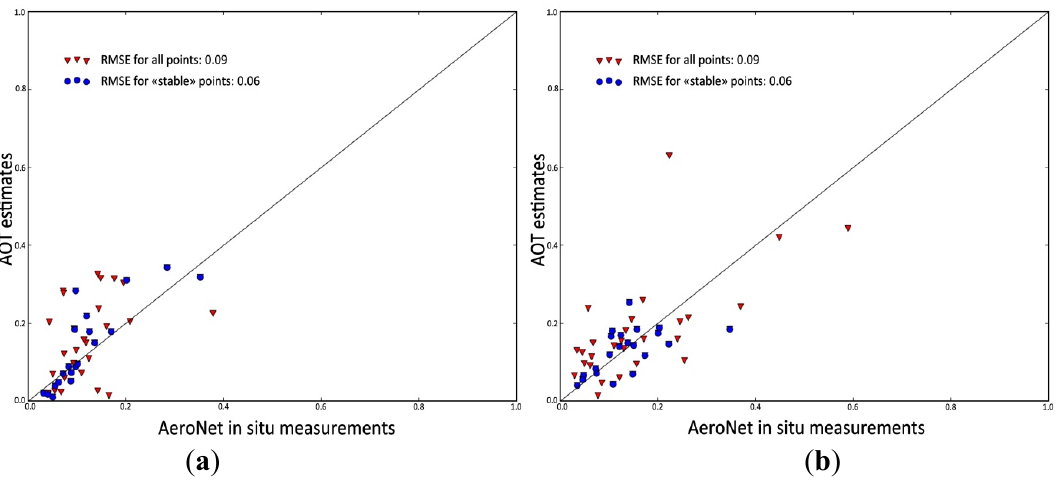
Figure 5. Validation of AOT estimates at 550 nm determined for ( a ) SPOT4 (Take 5) images (from [18]) and ( b ) Landsat 8 images using Aeronet in situ measurements .